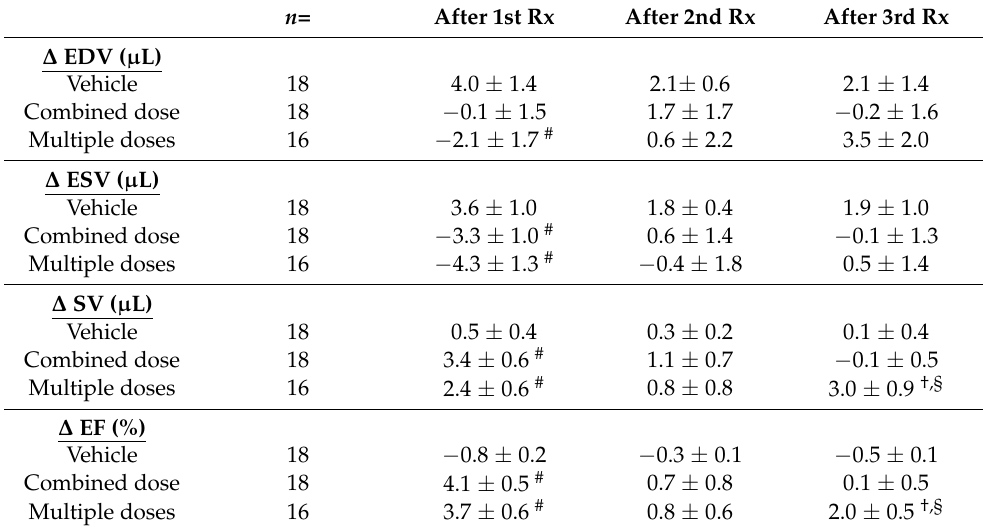
Table 2. Change in Echocardiographic Parameters after each